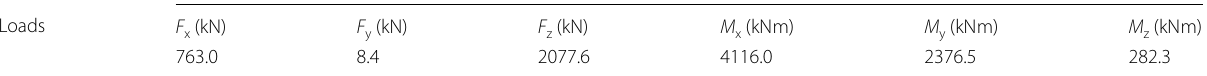
Table 3 Loads on the top of the tower.